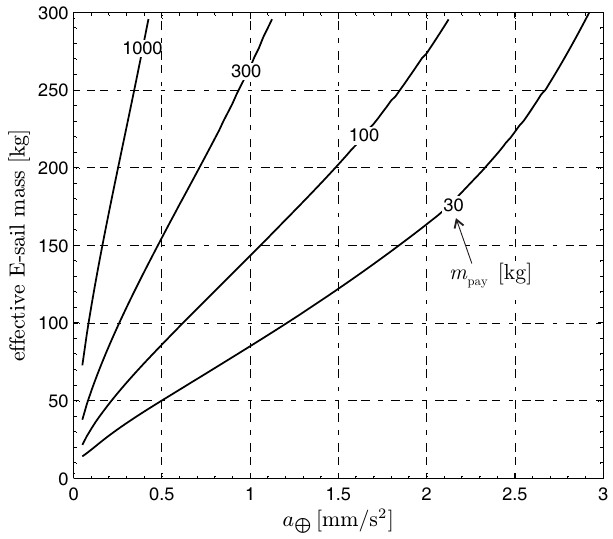
Fig. 5. Effective E-sail mass as a function of a ⊕ and m pay